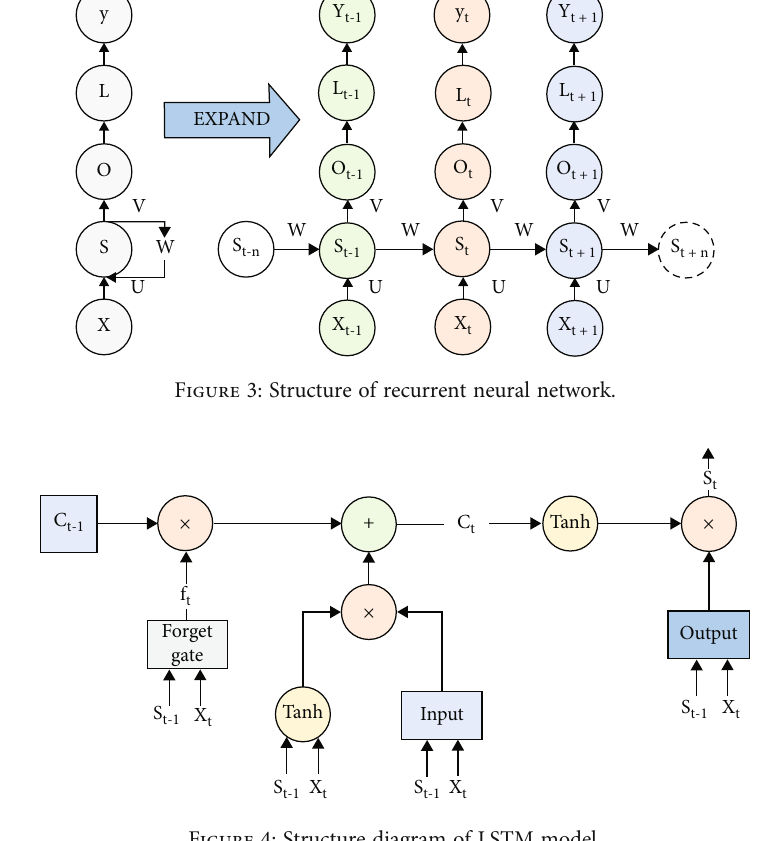
Figure 4: Structure diagram of LSTM